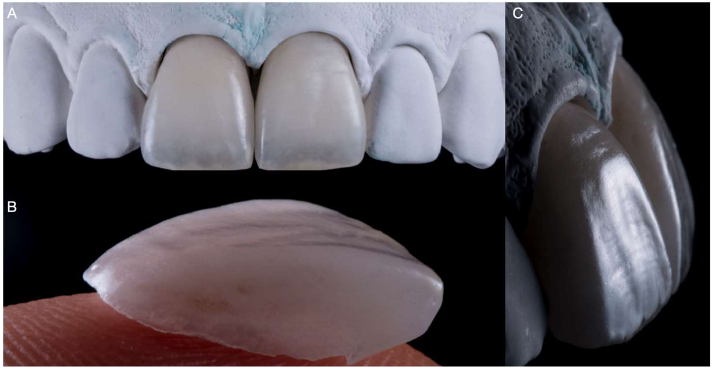
Figure 5. Permanent restorations: ultrathin ceramic laminate veneers. ( A ) Frontal view of veneers on master cast. ( B ) Close-up of a single veneer. ( C ) Lateral view of veneers on master cast. When creating ceramic dental restorations, color acquisition is critical in achieving a